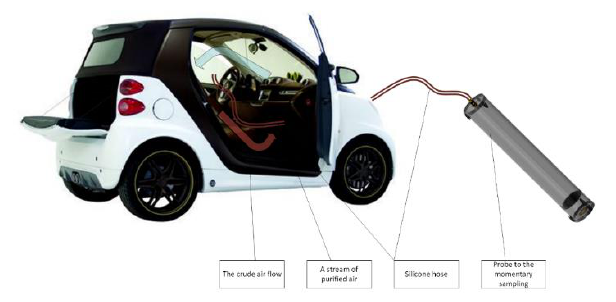
Fig. 4. Schematic representation of the experiment procedure [12]